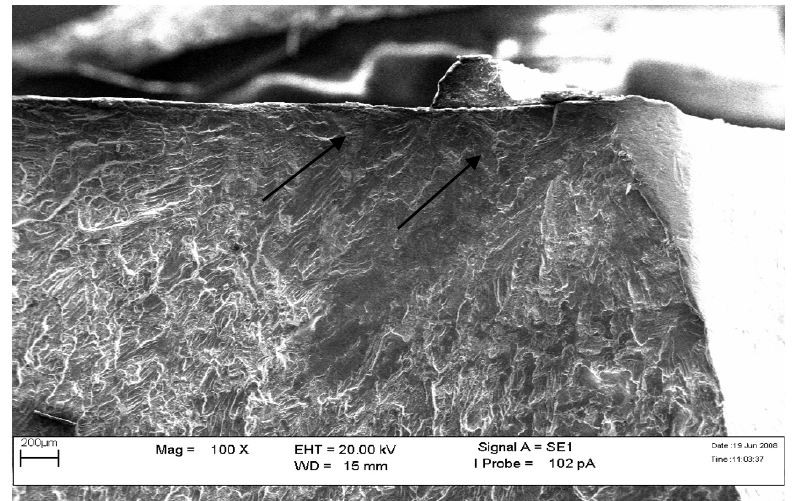
Figure 10. SEM image; arrow shows the fatigue striation (100×).